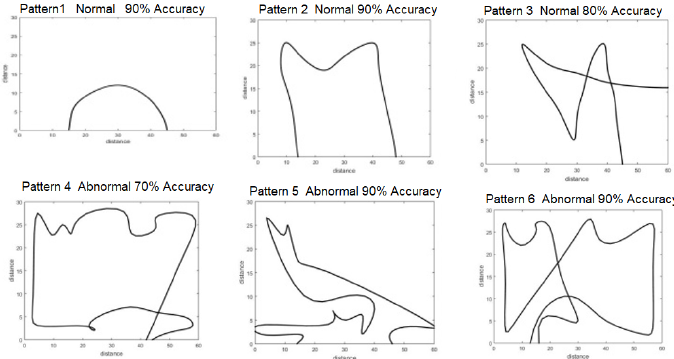
Figure 9. Different walking path scenarios with accuracy estimation.